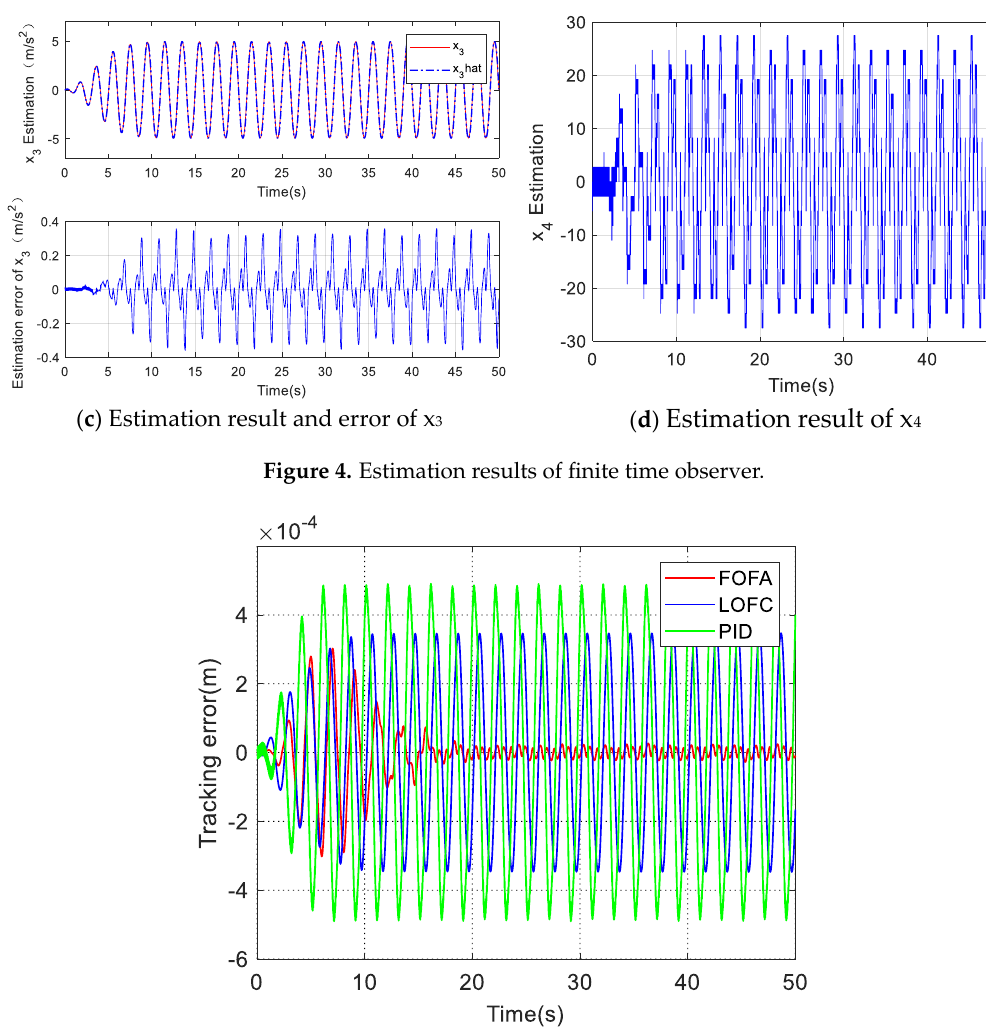
Figure 5. Comparison of position tracking error.